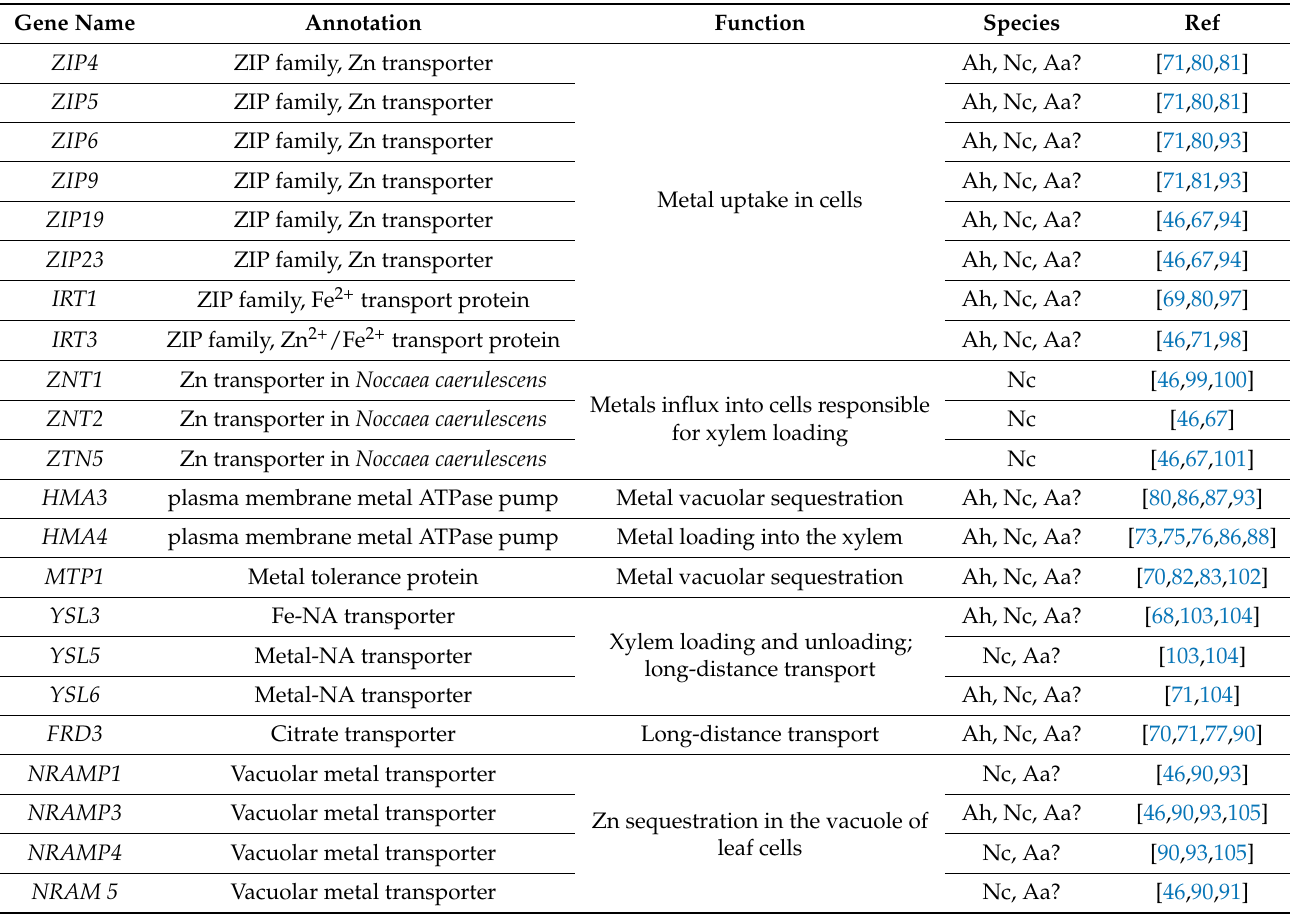
Table 1. Genes putatively assigned functional roles in mechanisms of heavy metal hyperaccumulation and hypertolerance in Arabidopsis halleri (Ah), Noccaea caerulescens (Nc) and Arabidopsis arenosa